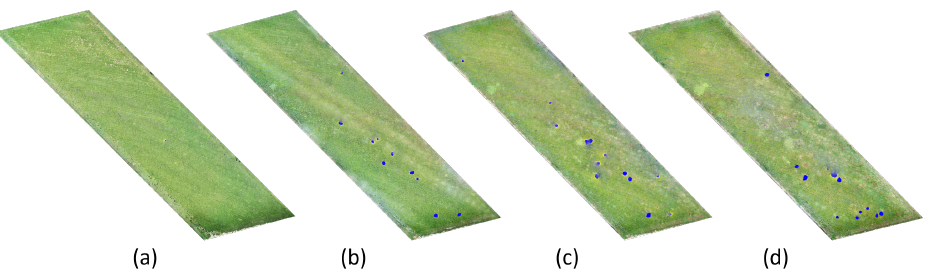
Figure 7. Segmentation results of Cuscuta spp. in the crop with input images of 320 × 320: ( a ) 14 July 2021, ( b ) 8 August 2021, ( c ) 29 August 2021, and ( d ) 11 September 2021.